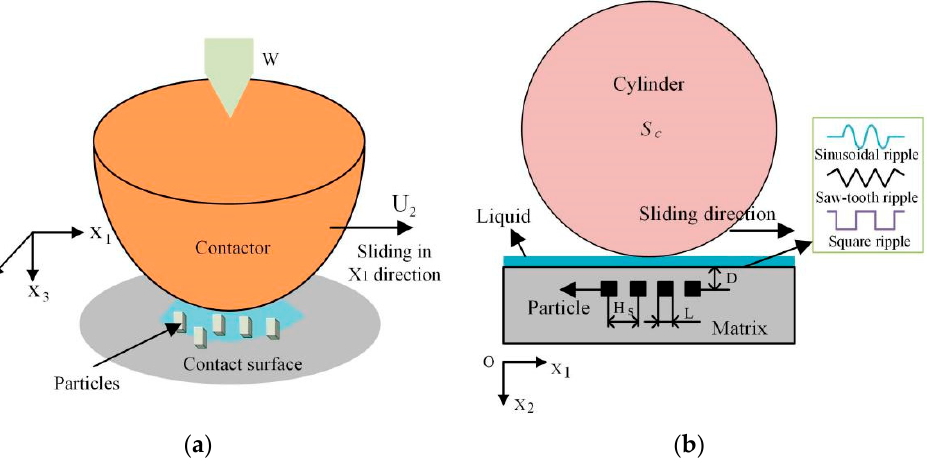
Figure 14. Elastohydrodynamic lubrication with particle-reinforced composite materials: ( a ) simpli- fied model of inclusion EHL problem; ( b ) EHL in line contact with different rough surfaces.